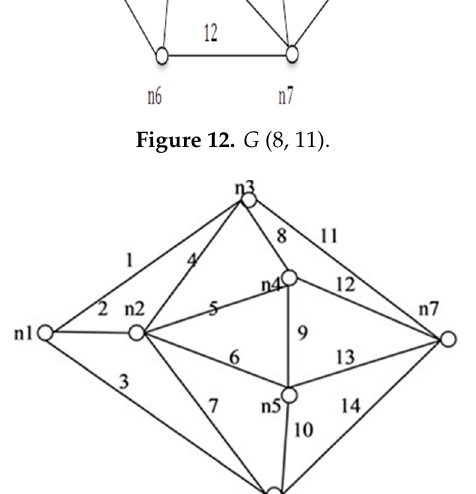
Figure 13. G (7, 14).